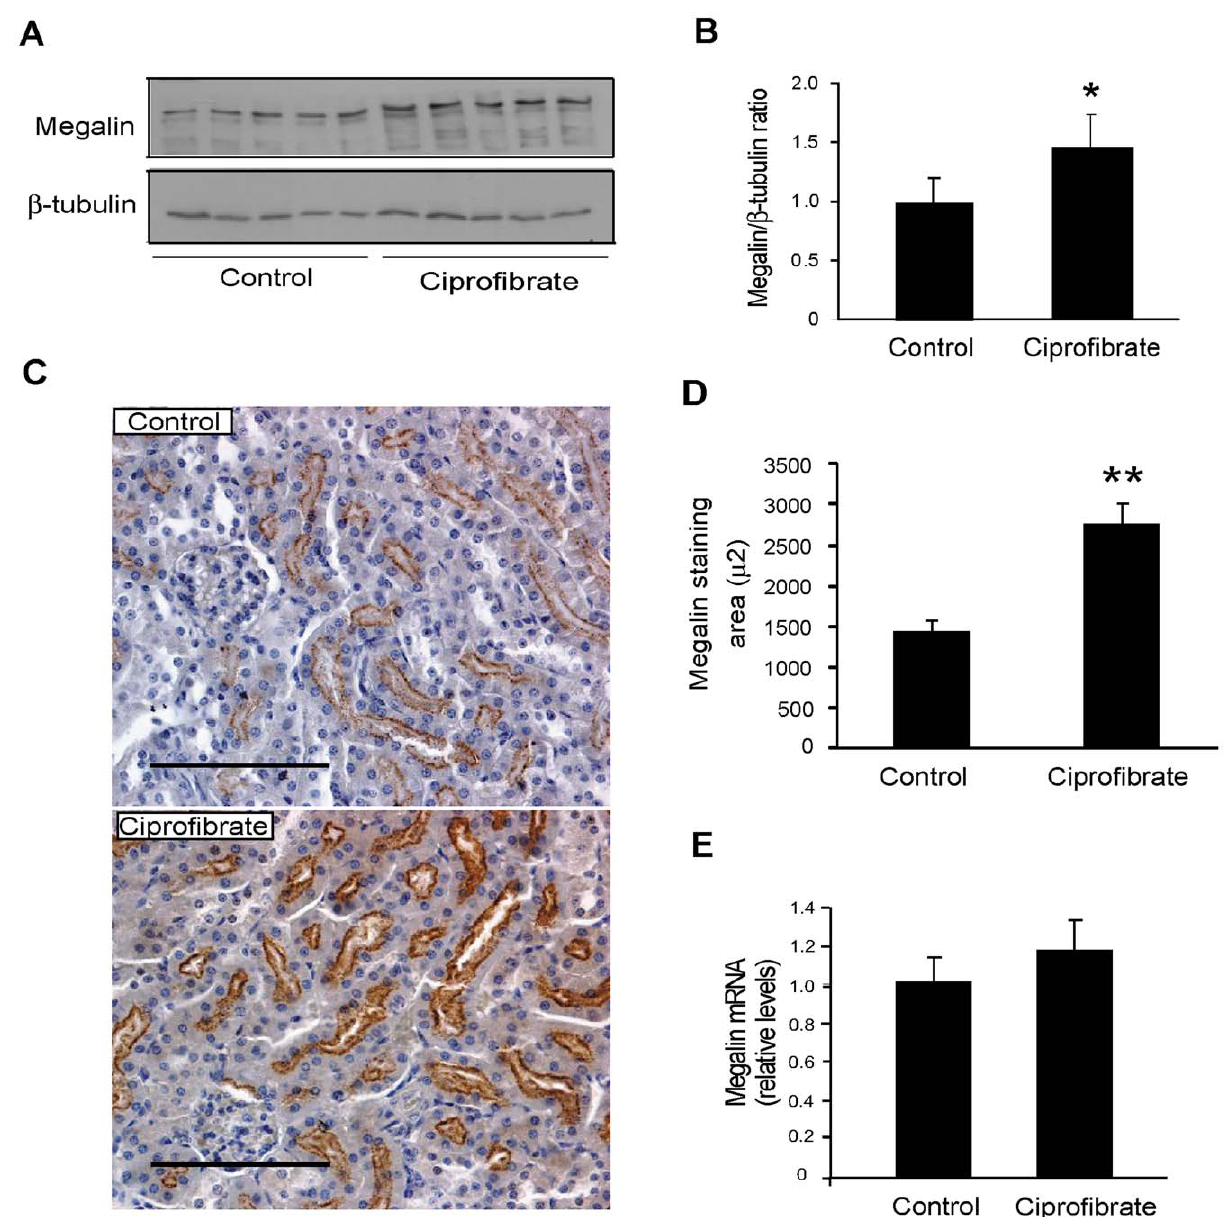
Figure 4. PPAR a agonists regulate megalin expression invivo in mice. BALB/c mice (n=3–5/per group) received ciprofibrate (200 mg/kg/ day) or vehicle for 1 week. ( a ) Kidney extracts were used to determine megalin protein levels by western blot, with b -tubulin used as loading control. ( b ) The bands in the blots were quantified by densitometry, and the results were plotted as the ratio of megalin/ b -tubulin for each condition. ( c ) Immunohistochemical staining for the megalin cytoplasmic domain in kidney sections (cortex) showed increased staining for megalin in ciprofibrate– treated mice compared to control mice. Bar=100 m m. ( d ) The megalin-immunostained area was significantly increased in the ciprofibrate group compared to the control group as measured by morphometric analysis. The quantification of the megalin-stained area is shown as m m 2 . ( e ) Megalin mRNA expression was determined from kidney RNA by qPCR. Data are expressed as means 6 SD. *P , 0.05 vs. control, **P , 0.0001 vs. control.